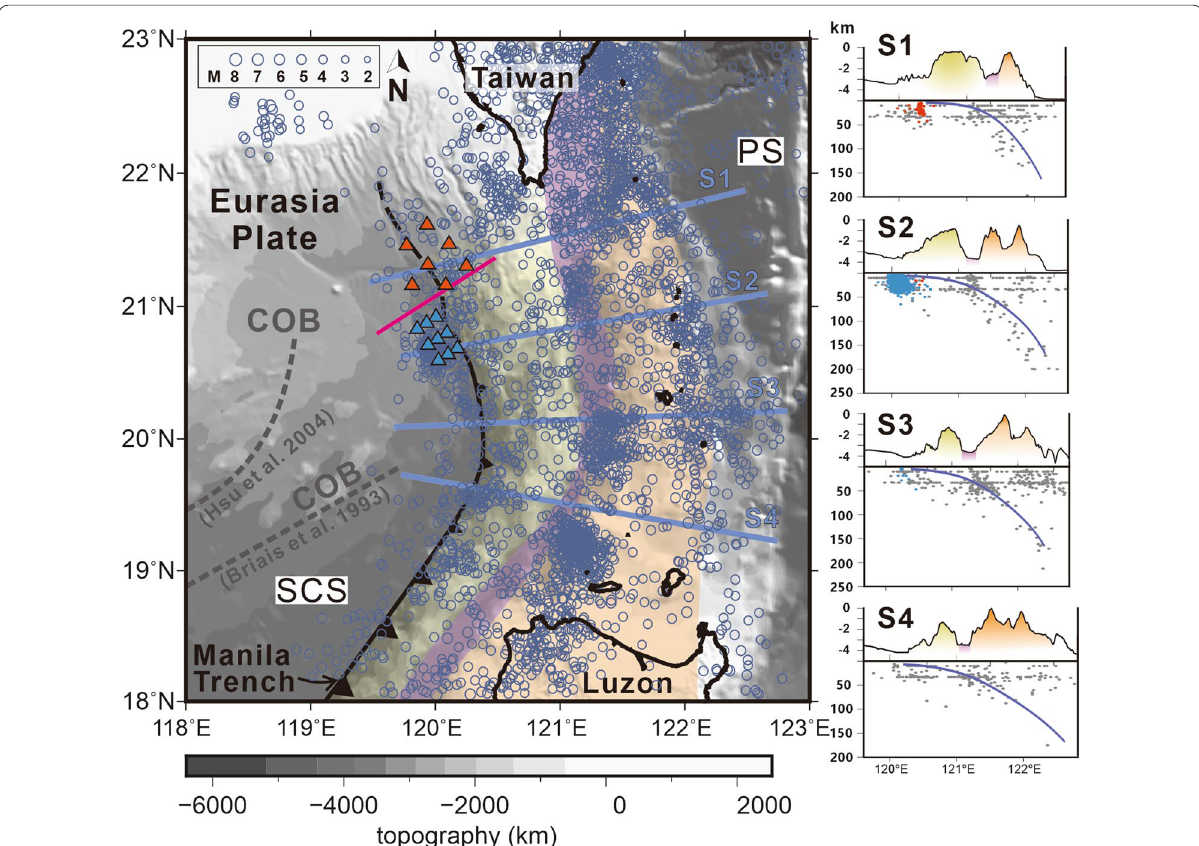
Fig. 1 Morphological map of the features of the northern SCS with four seismic cross-sections (right column, S1–S4). The shading indicates the geological units of the accretionary wedge (yellow), forearc basin (purple), and volcanic arc (light-brown). The red and blue triangles are the locations of the ocean-bottom seismometer (OBS) stations comprising the 2005 and 2006 networks. The seismicity of the United States Geological Survey catalog is indicated by the circles outlined in blue on the map and the gray dots in the four cross-sections. The red and blue dots on the cross-sections are the C2005 and C2006 earthquake sequences, respectively. The blue curves on the cross-sections indicate the subducting slab sourced from Model Slab 2.0 (Hayes 2018). The magenta line on the map indicates the profile location of Fig. 8. SCS South China Sea, PS Philippine Sea, and COB continent–ocean boundary (Hsu et al. 2004; Briais et al.